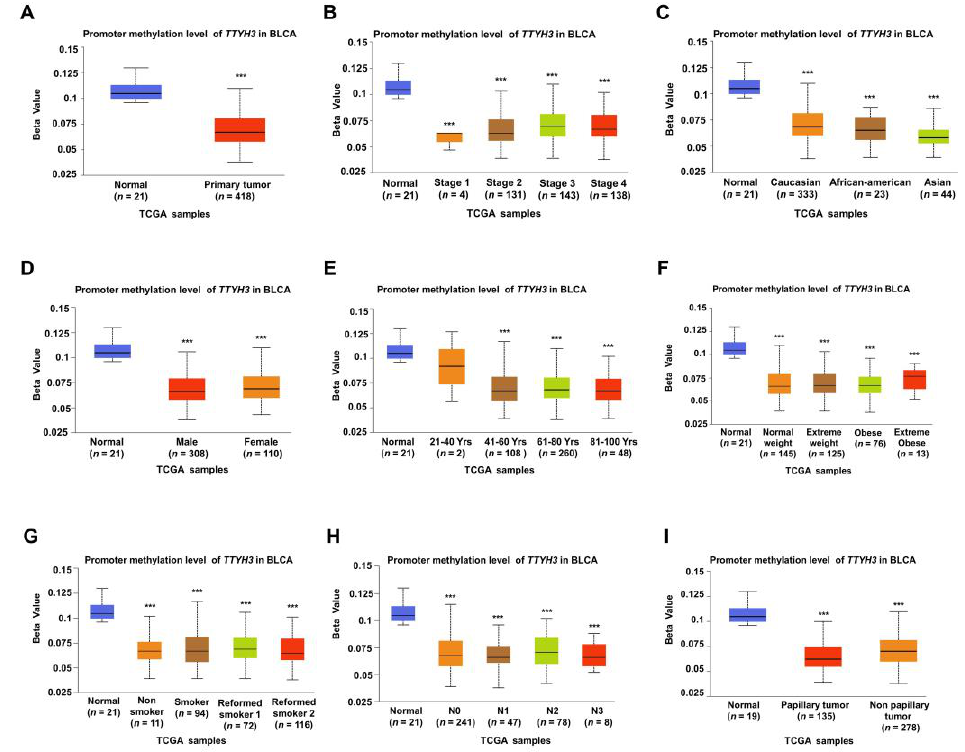
Figure A1. Promoter methylation of TTYH3 gene is significantly down-regulated in bladder cancer tissue. ( A ) The Cancer Genome Atlas (TCGA) clinical data from the UALCAN web tool were used to compare promoter methylation of TTYH3 in normal and bladder cancer patient tissues. The data were categorized based on individual cancer stages ( B ), patient’s race ( C ), patient’s gender ( D ), patient’s age ( E ), patient’s weight ( F ), smoking status ( G ), nodal metastasis status ( H ), histological subtypes ( I ). (*** p ≤ 0.001 ).